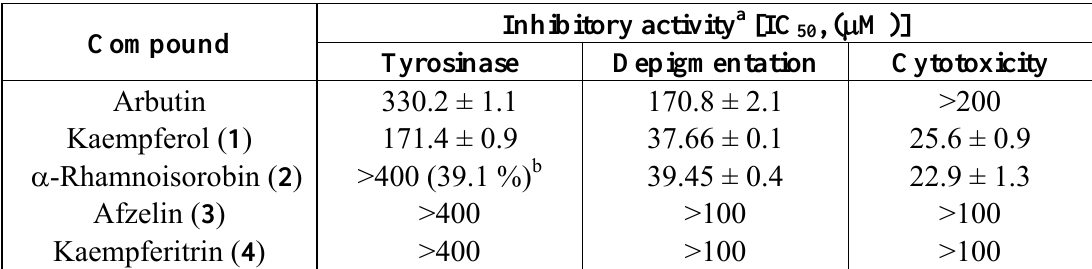
Table 1. Depigmenting activities of kaempferol and its rhamnosides.